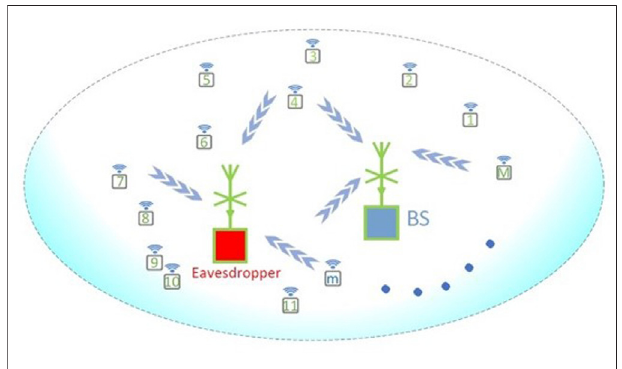
FIGURE 1 | A typical attack from the eavesdropper in uplink grant-free